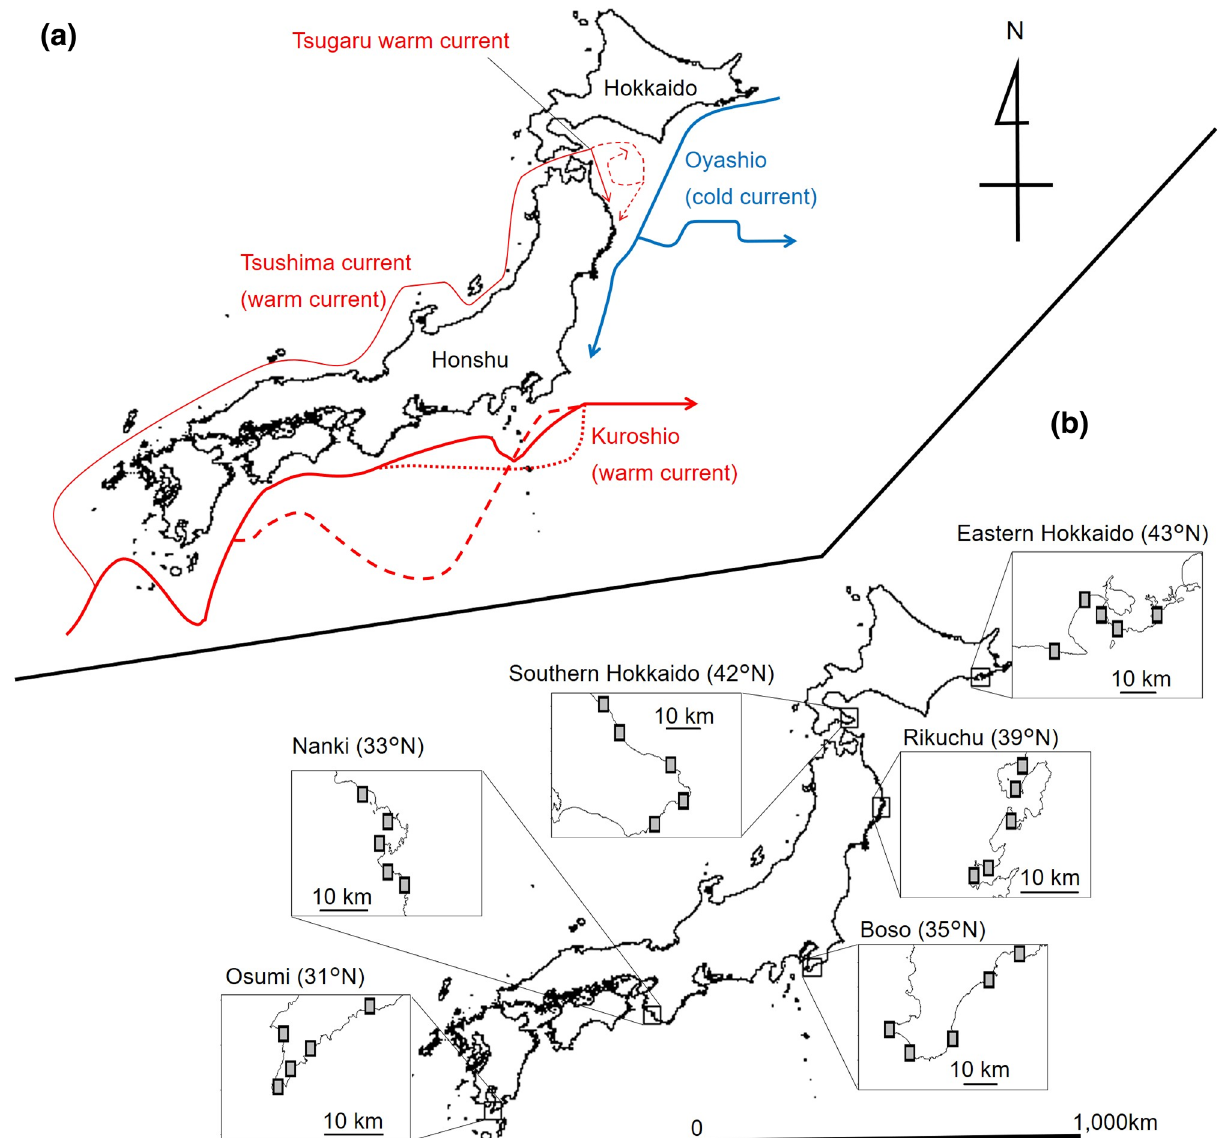
the census of intertidal sessile organisms in each region. The red solid and broken lines in ( a ) show alternative current paths. This figure was generated with R version 3.5.2 and the GADM database (www. gadm. org),